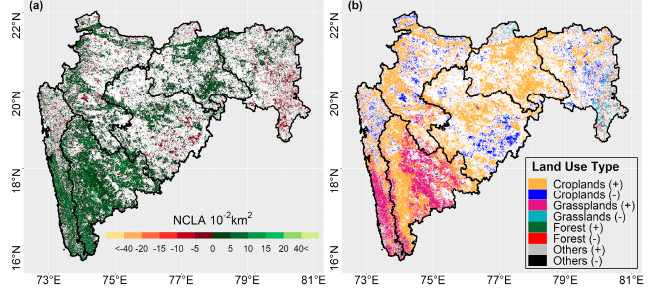
Figure 3. ( a ) Net Change in leaf area (NCLA) and ( b ) land use of each pixel showing significant positive (+) and negative ( − ) trends in MK trend analysis ( p < 0.05) of monthly time series